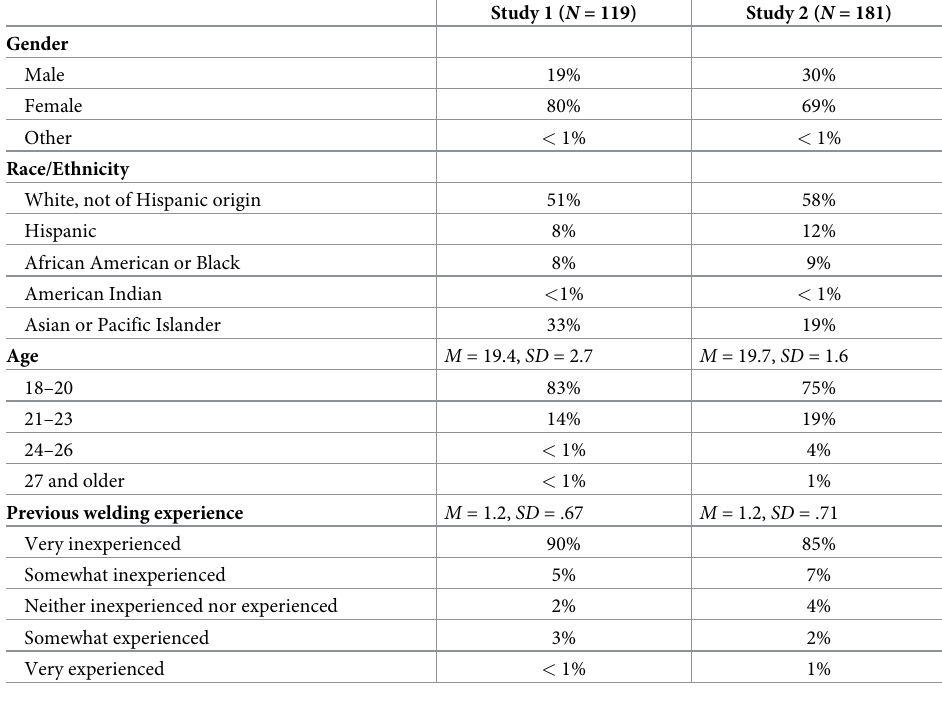
Table 1. Demographic information and welding experience of student samples in Study 1 and Study